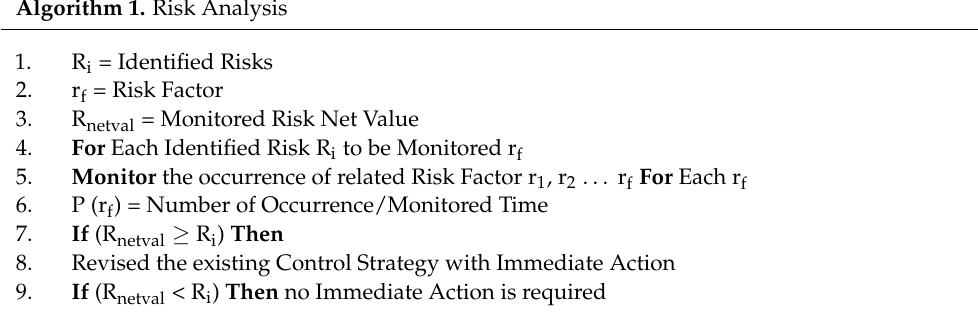
Algorithm 1. Risk